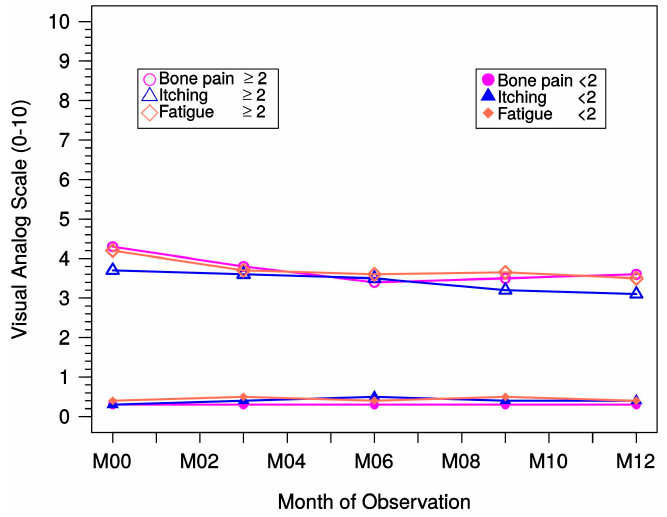
Figure 9. Medical symptoms of dialysis patients stratified by intensity of pain as measured using a VAS. M, month; VAS, visual analog scale.